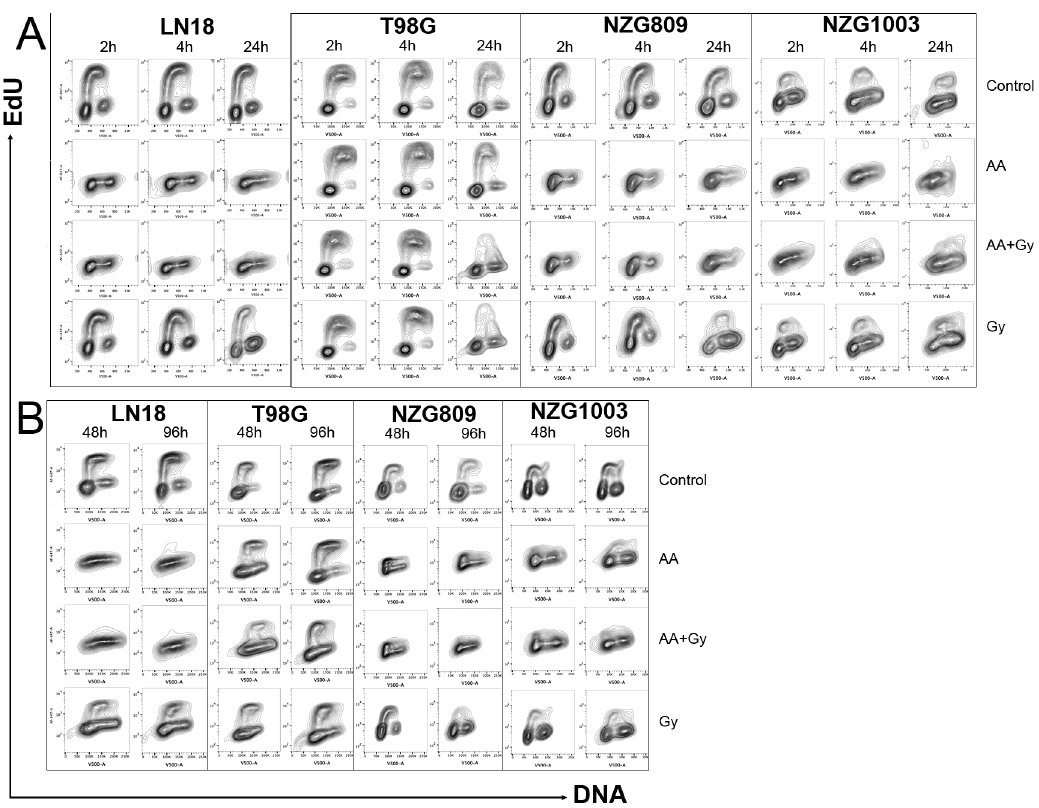
Figure 3. DNA synthesis indicated by EdU incorporation ( y -axis) and DNA content by nucleic acid content ( x -axis). G1 cells, with half the content of G2 cells are EdU negative, whereas cells undergoing synthesis have incorporated EdU into the newly synthesised DNA with subsequent increased signal. Cells were harvested at early time points ( A ) and late time points ( B ) after treatments. Flow cytometry plots are representative of at least three independent experiments.